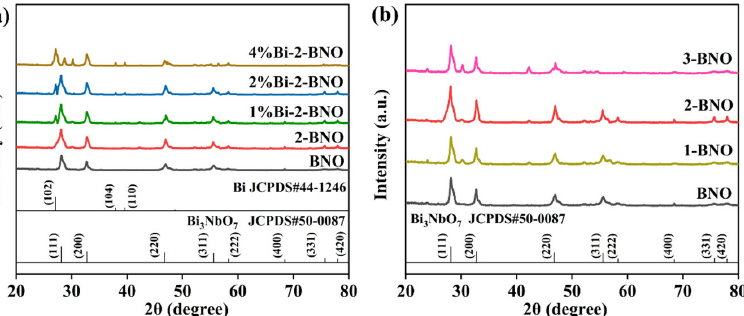
Figure 4. XRD patterns of the BNO photocatalyst with different amounts of urea ( a ) and of the 2-BNO sample with different amounts of Bi ( b ).